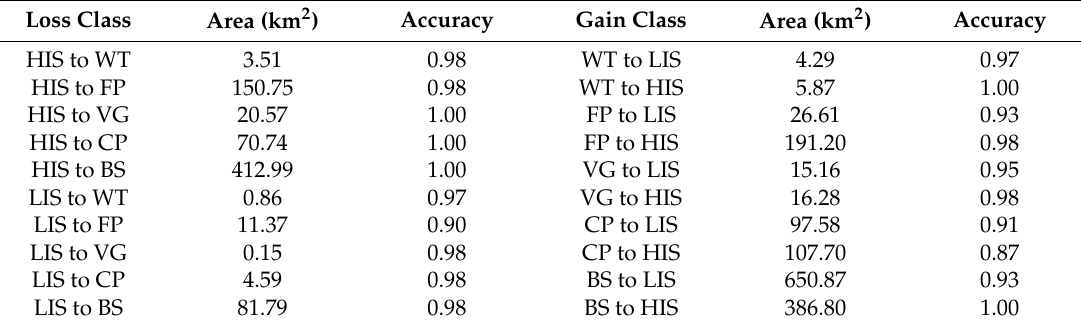
Table 5. Area and accuracy of each changed class (IS-related only).